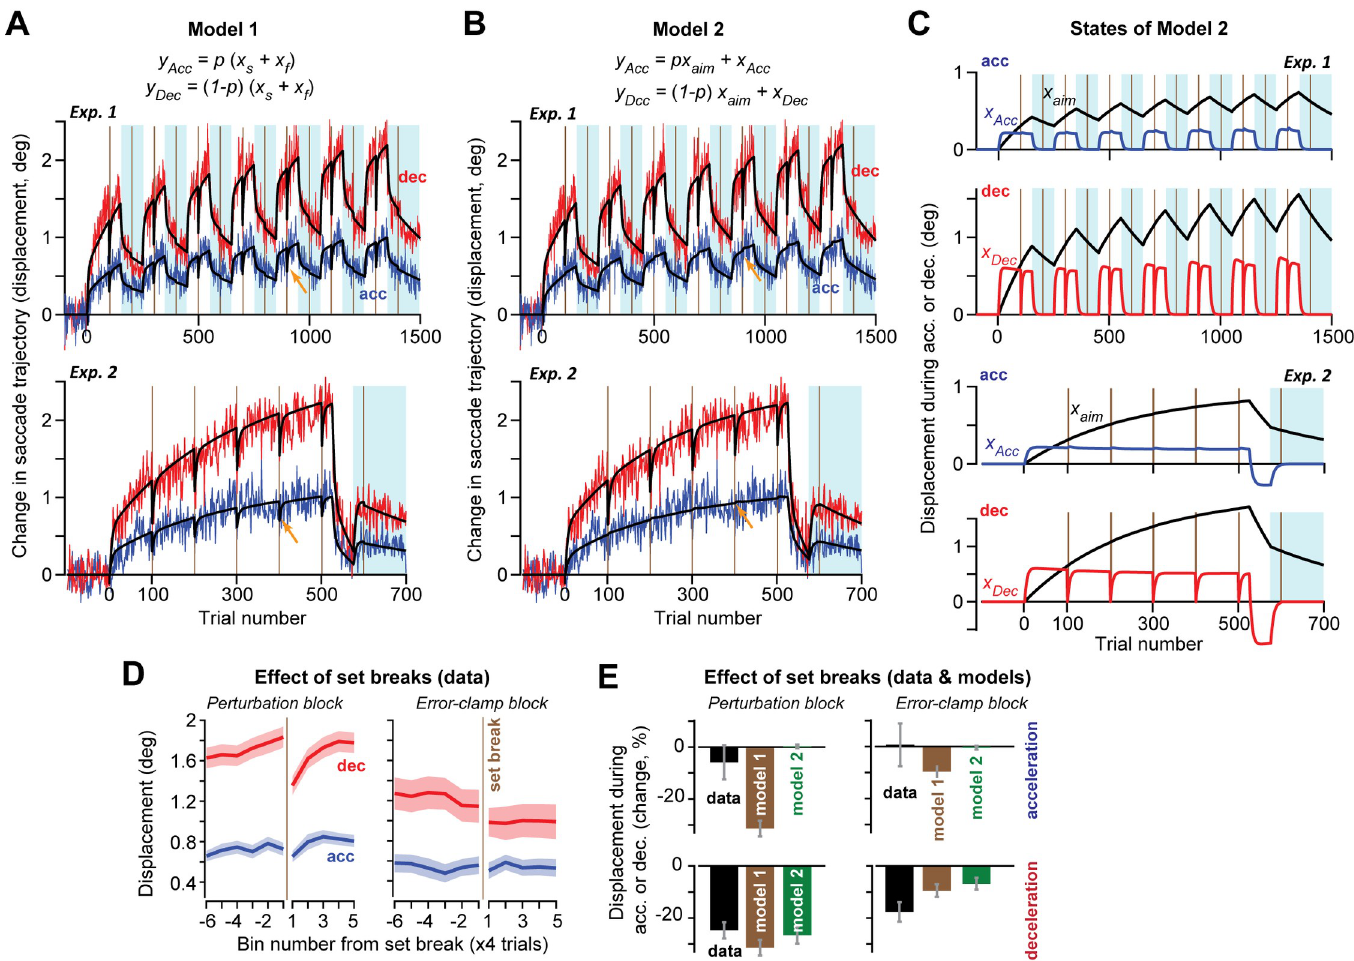
Fig 4. Two models of adaptation. A . Model 1 represented a single controller that learned from error via a fast state x and a slow state x . During a saccade, a fraction of f s the sum of the two states was expressed during acceleration, and the remainder was expressed during deceleration. Arrow indicates the effect of set break on the model’s acceleration period commands. B . Model 2 relied on two controllers, one that aimed the saccade with state x aim , and another that independently affected the commands during the acceleration and deceleration periods. C . States of Model 2 during Exps. 1 and 2. Model 2 could account for the observation that set breaks produced a loss in the deceleration period but not the acceleration period commands. In addition, Model 2 accounted for the observation that decay following a set break differed in perturbation vs. error clamp trials: note the difference in x at set breaks during perturbation and error clamp blocks of Exp. 1). D . Measured set break decay data. Dec Adaptation is shown aligned to set breaks during perturbation periods in Exps. 1 and 2 (left) and error clamp periods in Exp. 1 (right). E . Comparison of the set break effects in the models and the measured data. The models differed in their ability to account for acceleration period set break decay. Error bars for data are SEM. Participants from Exps. 1 and 2 were combined when analyzing the perturbation block set breaks. For error clamp block set breaks, only participants from Experiment 1 were